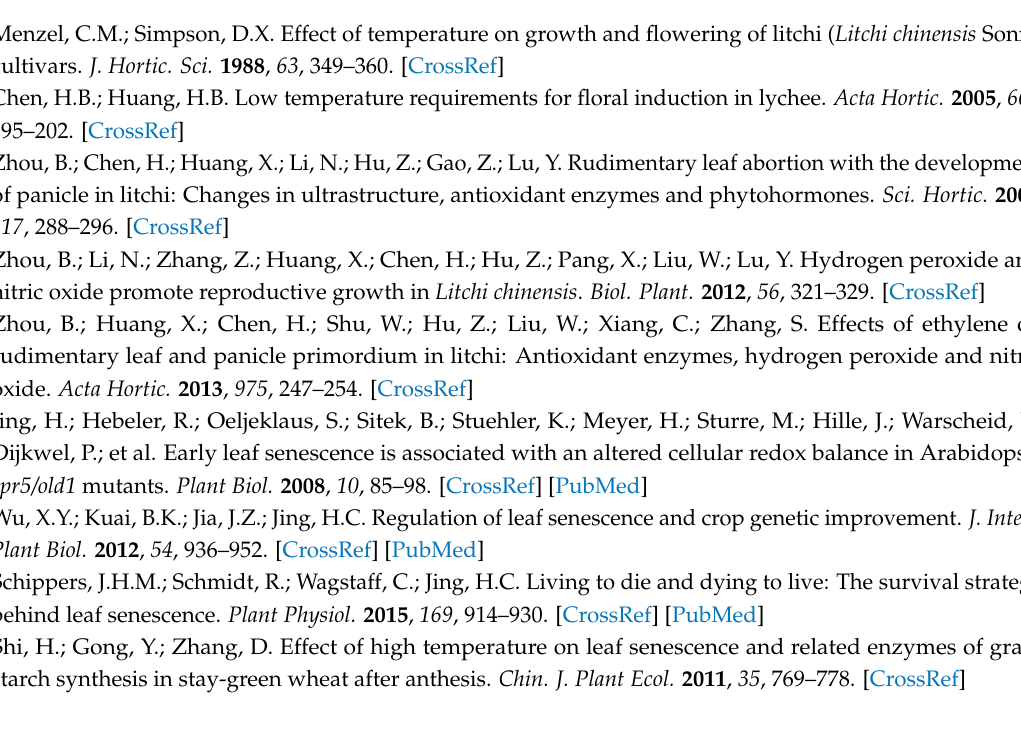
Table S1: Primer sequences of the reference and candidate genes for qRT-PCR, Figure S1: Correlation analysis of the sequencing samples, Figure S2: Gene ontology analysis of differentially expressed genes in the panicle leaves, Figure S3: Heat map diagram showing the JA-related differentially expressed genes (DEGs) between senescing and developing panicle leaves, Figure S4: Heat map diagram showing the SA-related differentially expressed genes (DEGs) between senescing and developing panicle leaves, Figure S5: Heat map diagram showing the BR-related differentially expressed genes (DEGs) between senescing and developing panicle